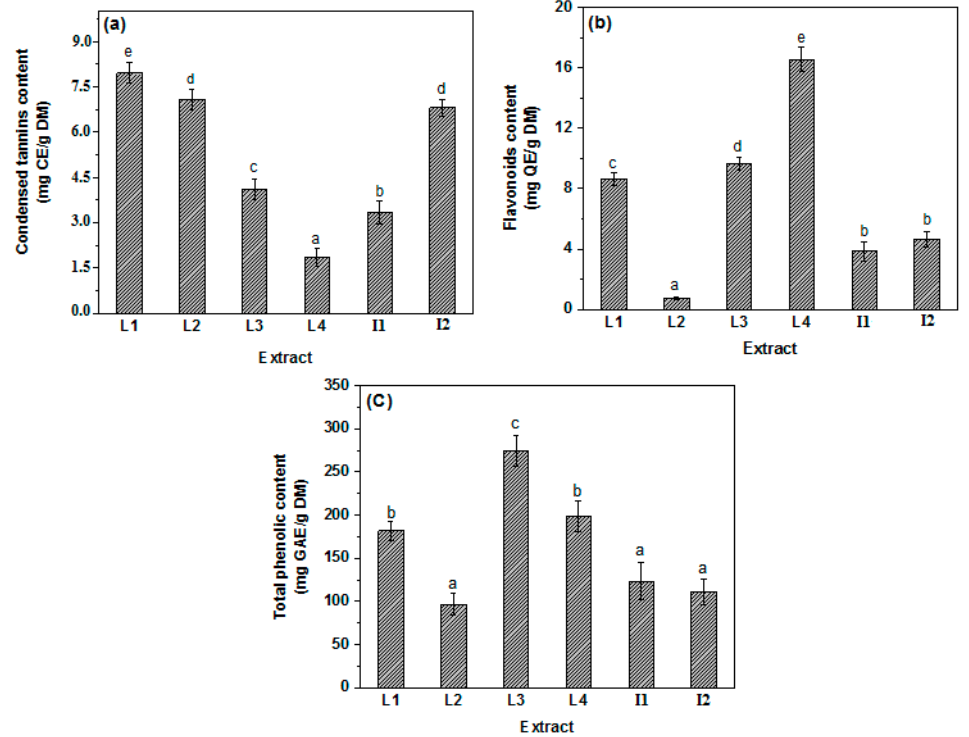
Figure 3. Condensed tannins (mg of catechin equivalent/g of dry matter) ( a ), flavonoids (mg of quercetin equivalent/g of dry matter) ( b ) and total phenolic compounds (mg of gallic acid equivalent/g of dry matter) ( c ) contents; values with different letters a, b, c, d, e for each graph are statistically different (Duncan test, p = 0.05).